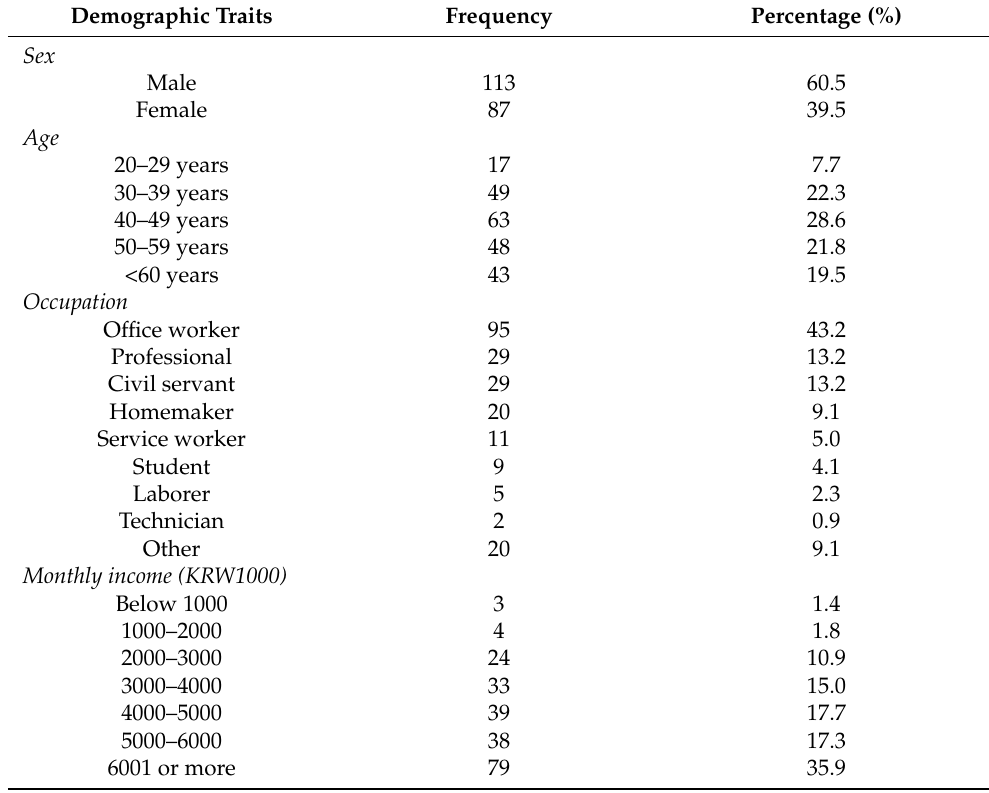
Table 1. Profile of respondents.